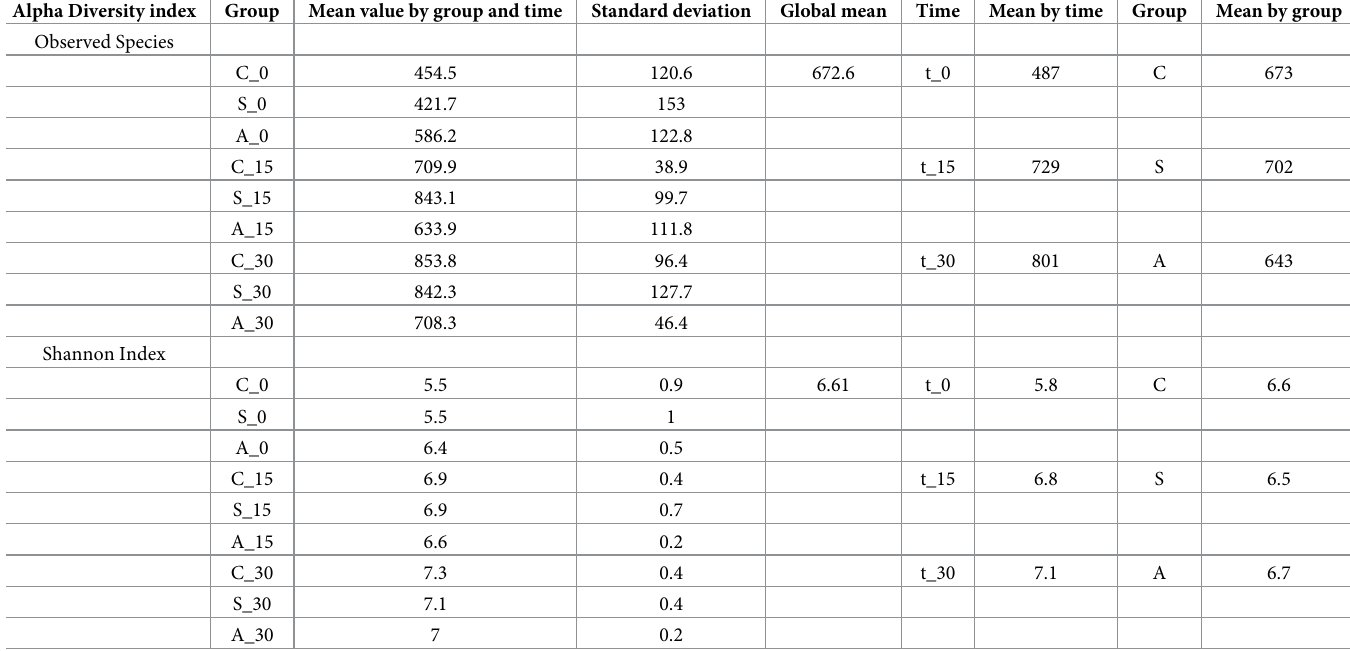
Table 2. Alpha diversity indexes obtained for the individual samples and mean values for all the samples and samples grouped by time point or treatment. C, S and A are control, feed additive and antibiotic group, respectively. Alpha Diversity